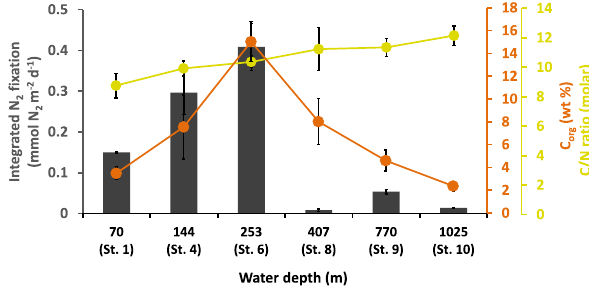
Figure 5. Integrated nitrogen fixation (mmolN 2 m − 2 d − 1 , grey bars, average of three replicates), average organic carbon content (C org , wt%, orange curve) and the average C / N molar ratio (yel- low curve) from 0 to 20cm along the depth transect (m). Error bars indicate standard